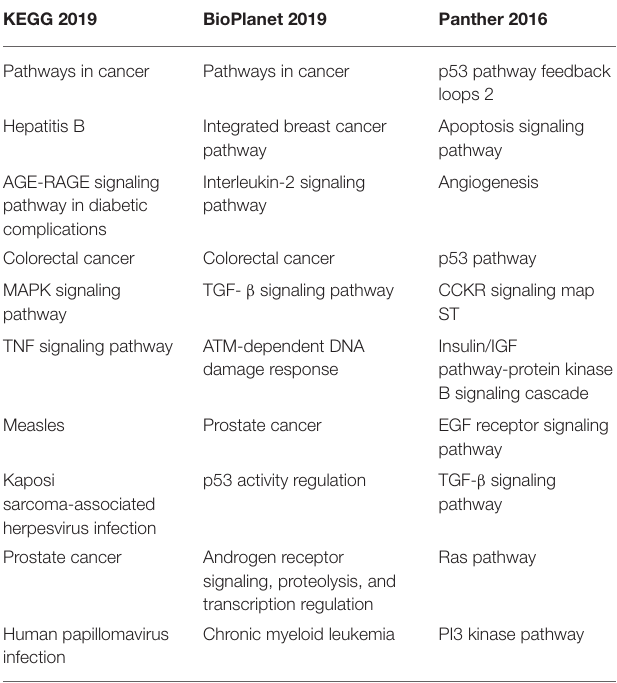
TABLE 3 | Top enriched pathways defined by gene targets of differentially expressed miRNA in studies investigating serum and plasma